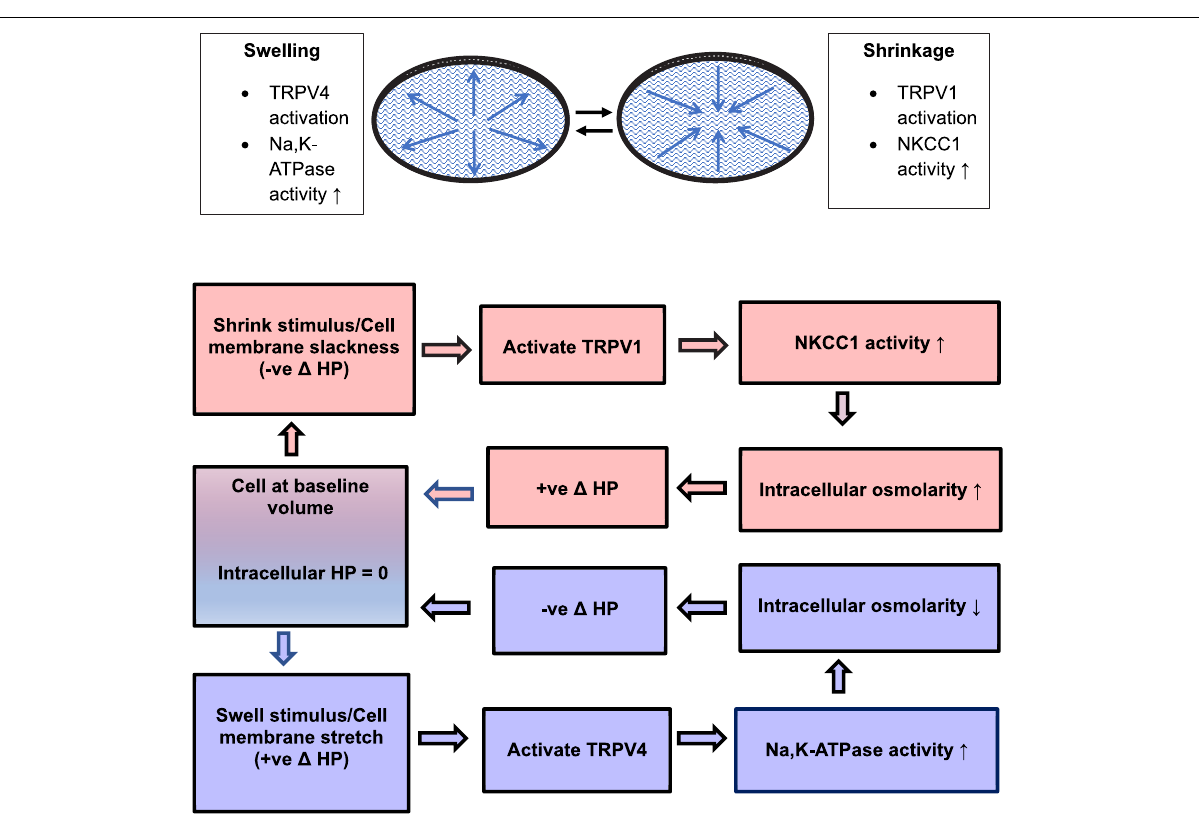
FIGURE 4 | To maintain a steady state, the lens may sense and respond to minor episodes of swelling and shrinkage by means of a TRPV4 mechanism that regulates Na, K-ATPase activity and a TRPV1 mechanism that regulates NKCC1 activity. TRPV4 and TRPV1 are activated by increases or decreases of intracellular hydrostatic pressure (HP) in lens surface cells. The feedback loops return HP to